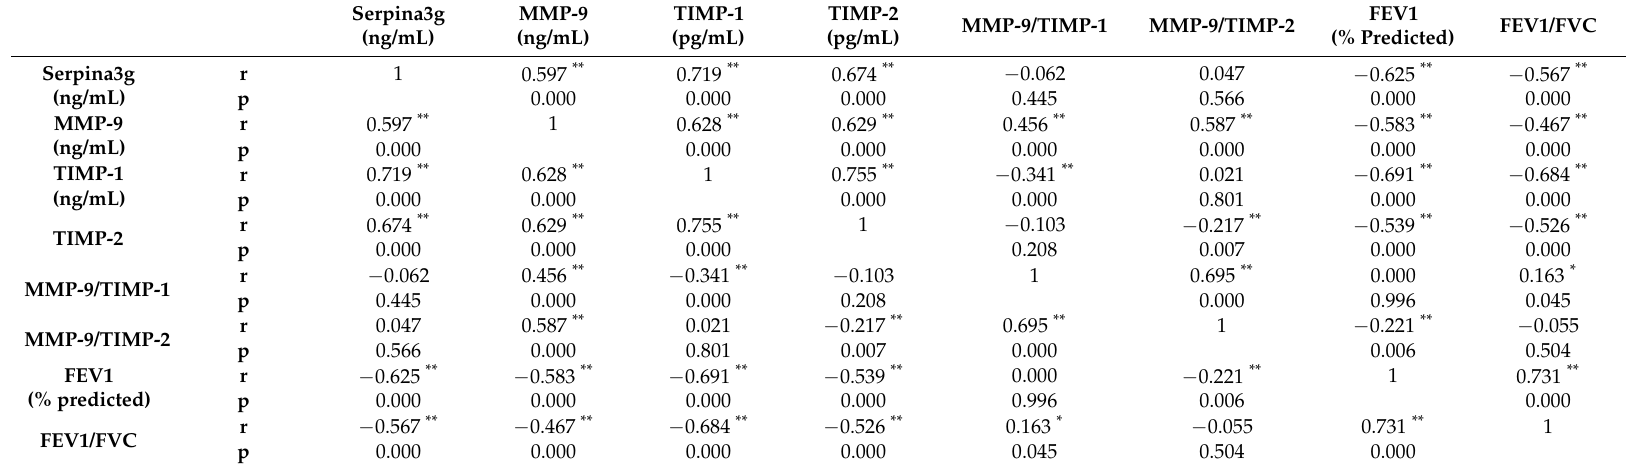
Table 3. Correlation analysis between protease–antiprotease levels and FEV1 and FEV1/FVC in all